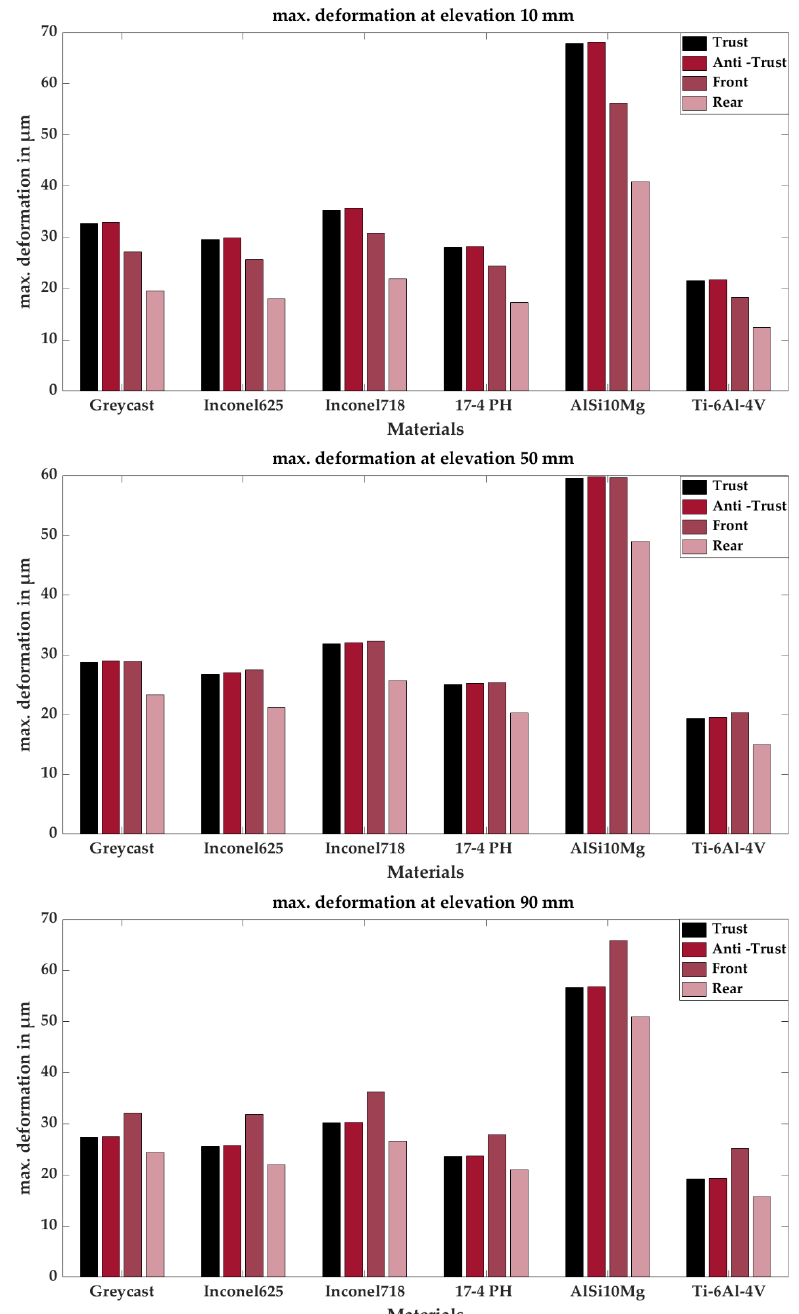
Figure 3. Maximum deformation at 10, 50 and 90 mm from the top.